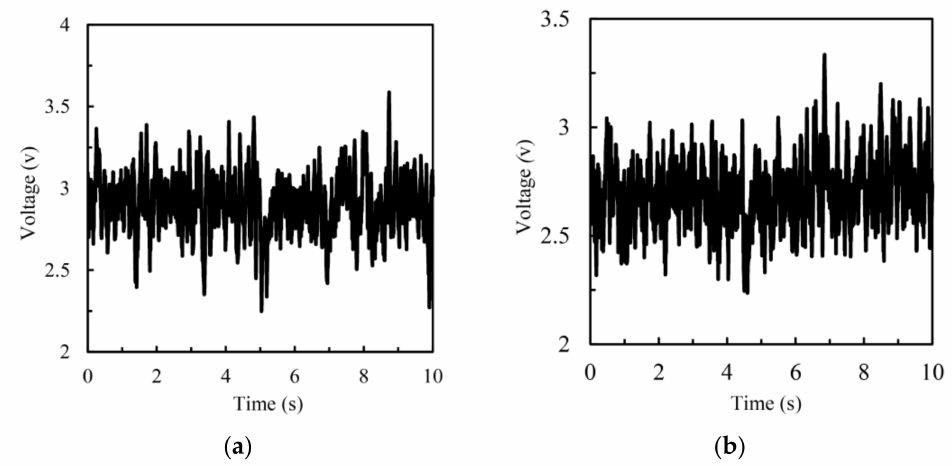
Figure 19. Voltage signal: ( a ) small-scale O-specimen; ( b ) small-scale